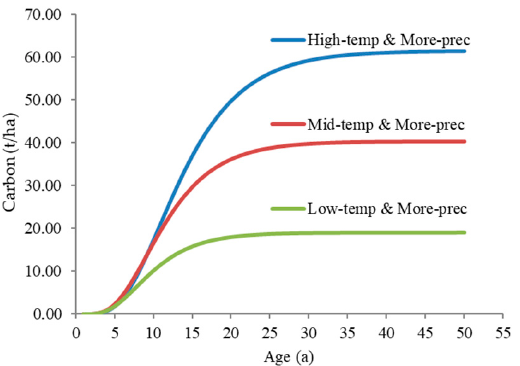
Figure 8. Growing process of carbon storage in Larix plantation under three climate